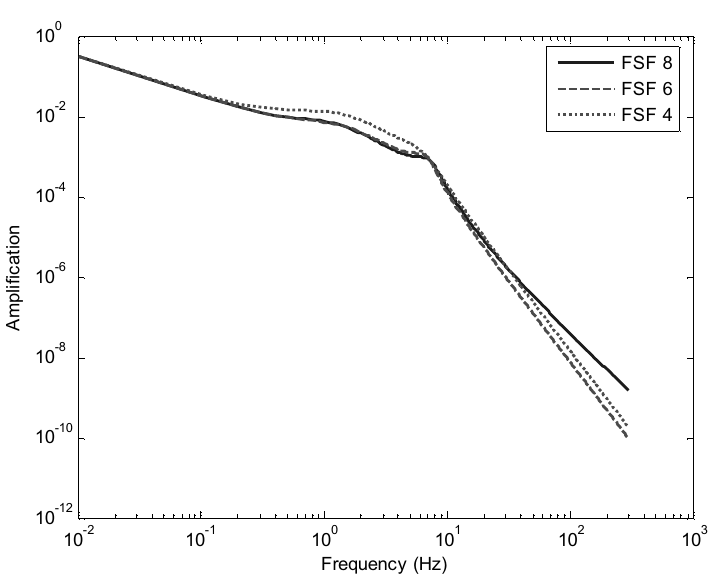
Fig. 10. Roll angle for right road